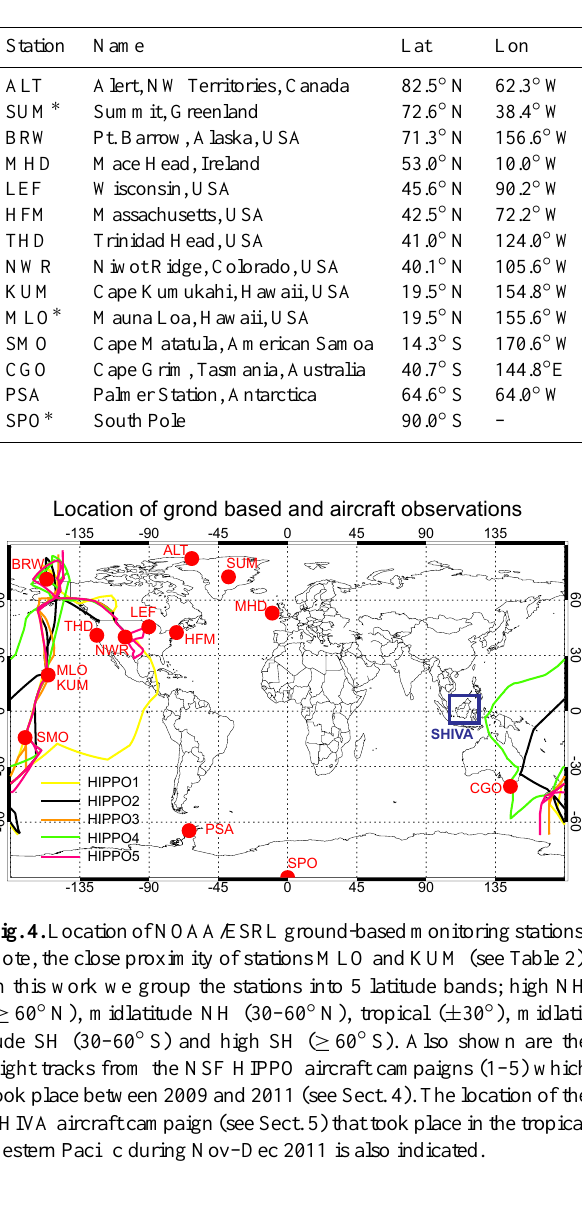
Table 2. Summary and location of NOAA/ESRL ground-based sta- tions arranged from north to south. * Stations SUM, MLO and SPO elevated at ∼ 3210, 3397 and 2810m respectively.